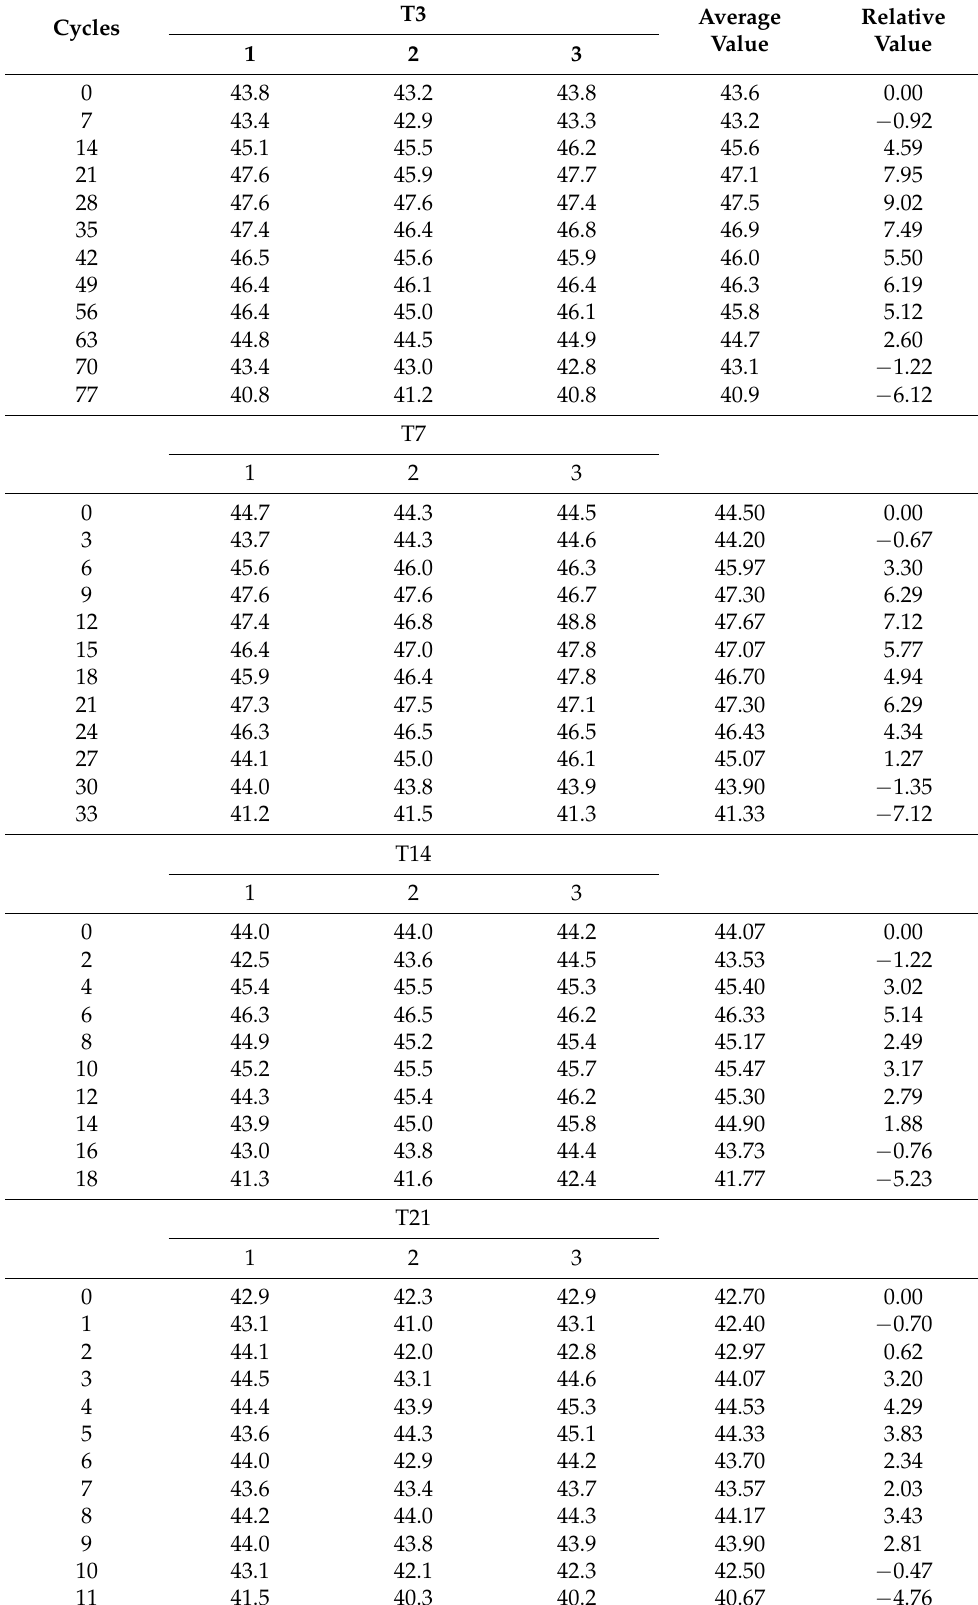
Table 5. The dynamic elastic modulus in the experiment (Ed/ × 1000